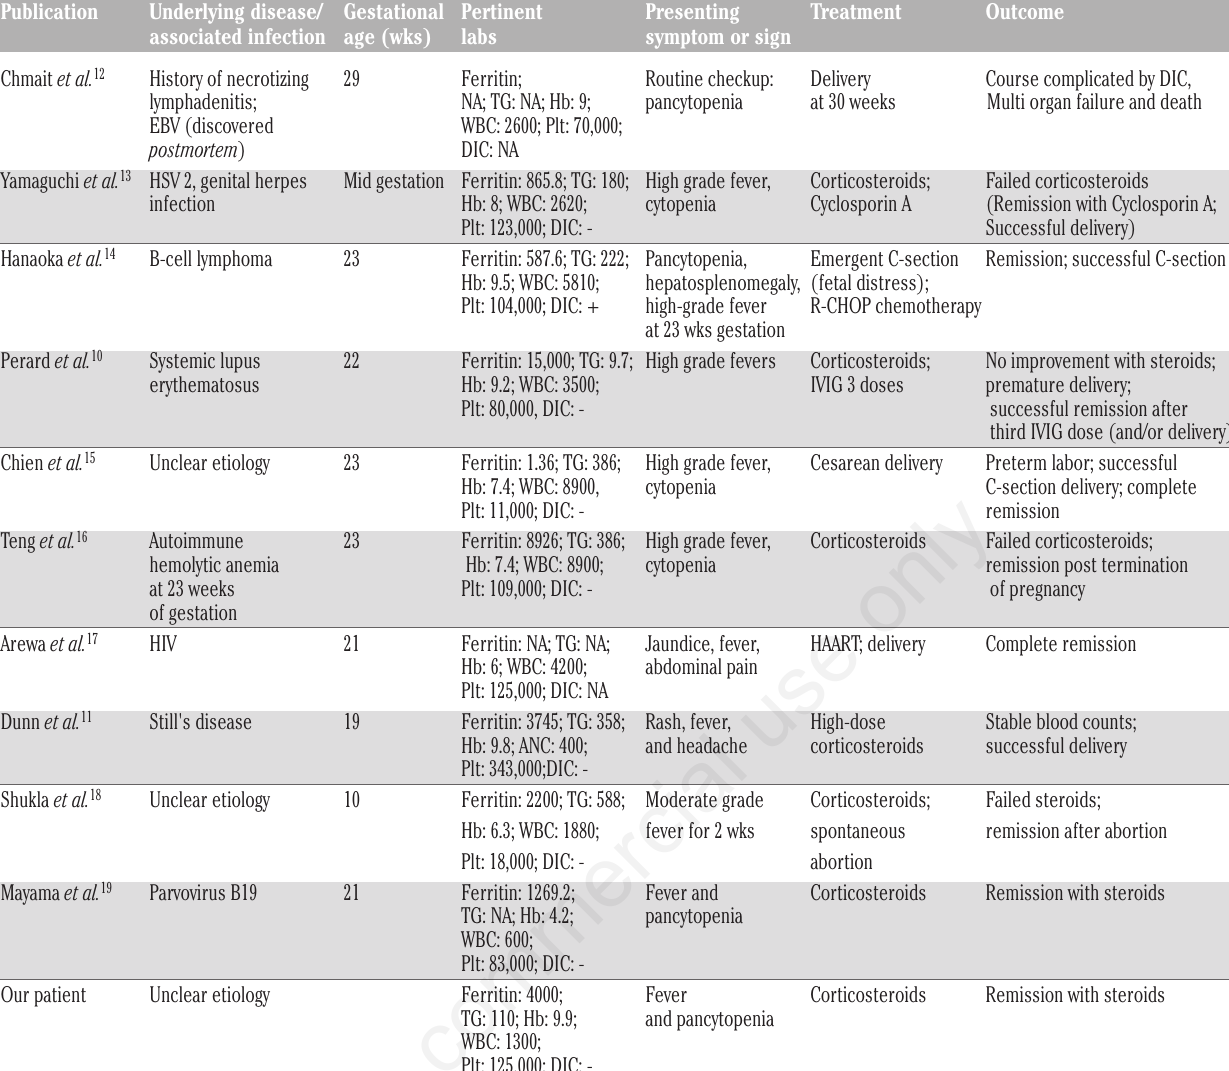
Table 2. Reported cases of hemophagocytic lymphohistiocytosis during pregnancy and their characteristics. Publication